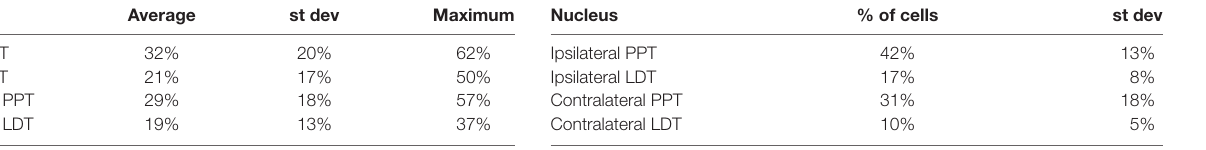
Frontiers in Neural Circuits |